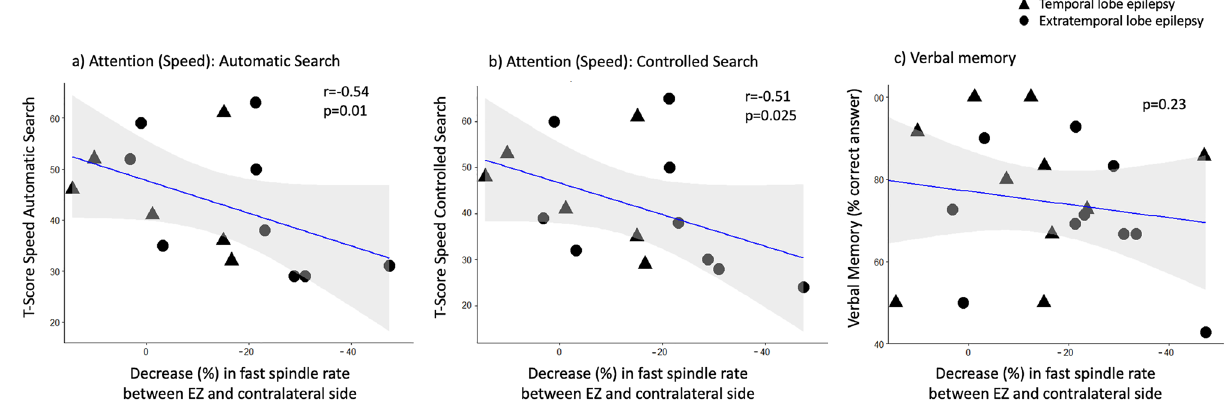
Figure 4. Correlation between decrease (%) in fast spindle rates (region with the epileptic focus compared to contralateral side) in N2 sleep and ( a ) selective attention task for speed subscale “automatic search”, ( b ) selective attention task for speed subscale “controlled search” and ( c ) verbal memory test. Grey shading represents 95% confidence